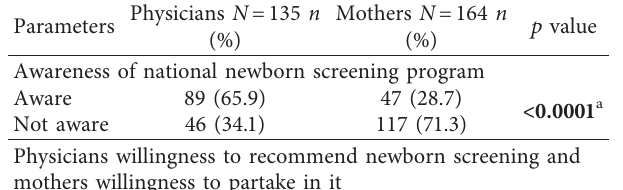
Table 2: Mothers’ demographic characteristics, awareness, and perception of early SCD diagnosis.